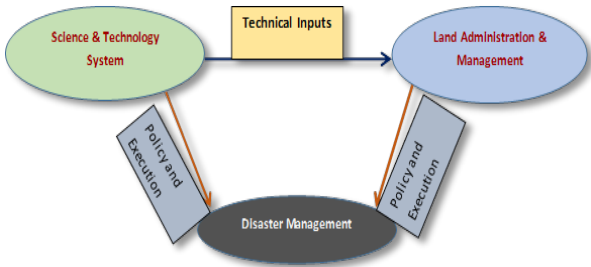
Figure 1: Conceptual Diagram of Disaster